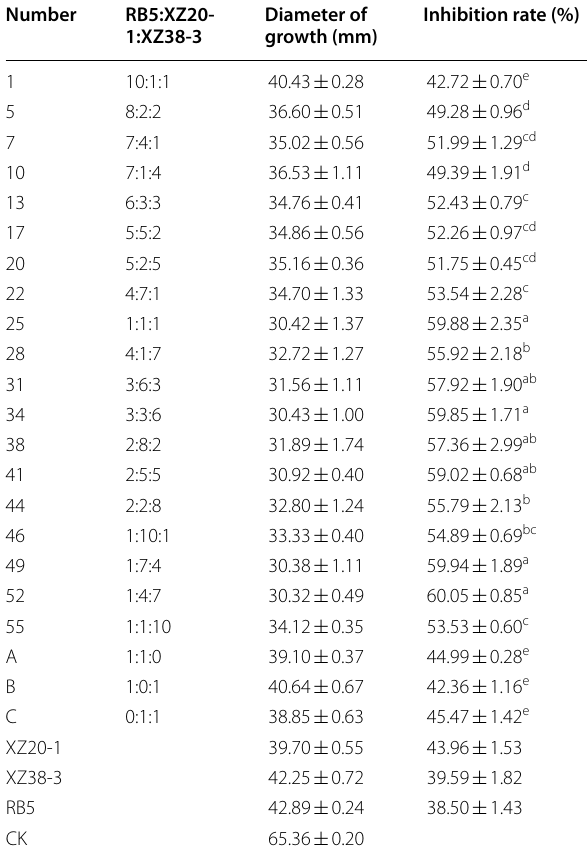
Table 1 Ratio of each group and their inhibition rates against Rhizoctonia cerealis